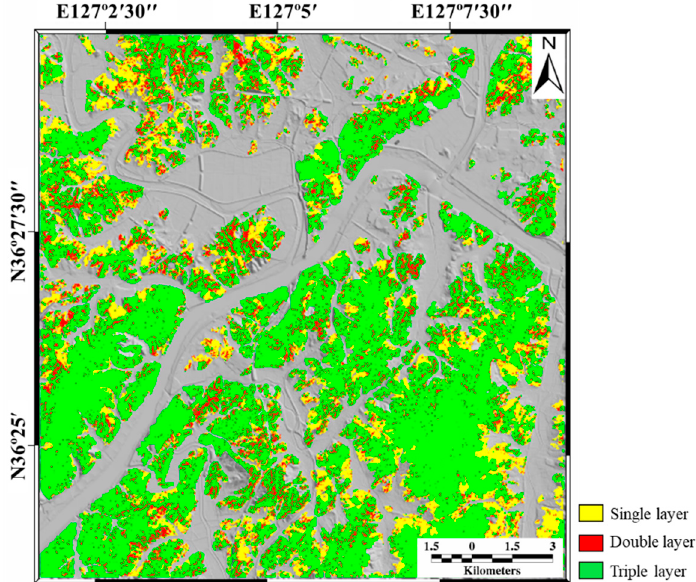
Figure 12. Forest vertical structure map classified from forest vertical probability maps using the maximum operation.